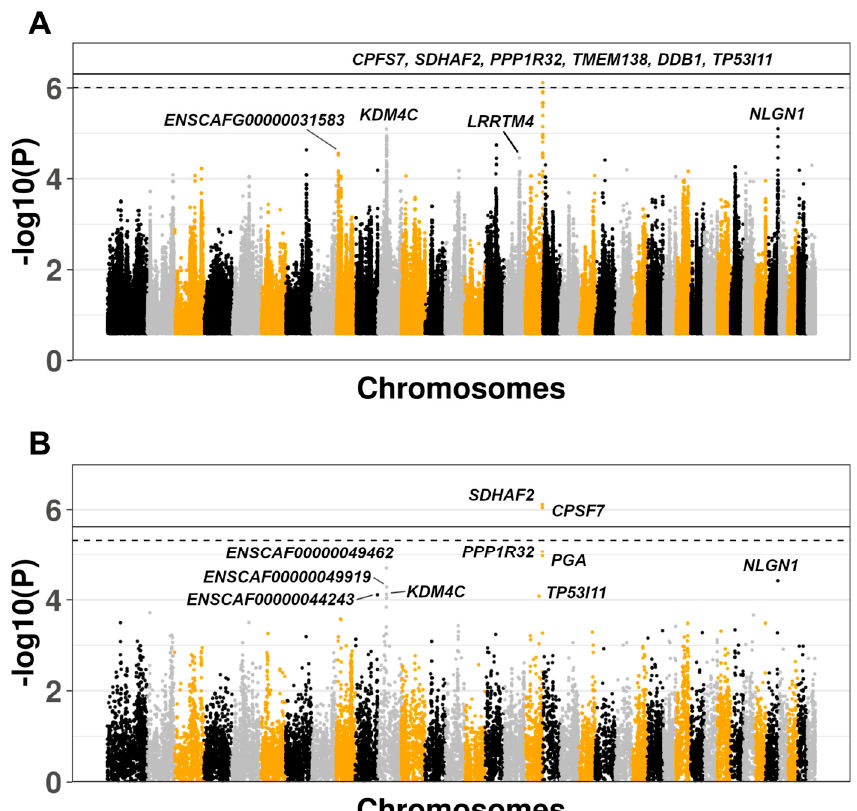
Figure 1. ( A ) SNP level analysis: Manhattan plot of the top 500K SNPs ranked by unadjusted p -value. The continuous and dashed lines indicate the genome-wide ( p < 4.91 × 10 − 7 ) and suggestive ( p < 9.83 × 10 − 7 ) significance thresholds, respectively. The p -value adjustment was conducted using the Bonferroni method, accounting for 101,740 independent SNPs estimated using regional linkage disequilibrium (LD) patterns. Gene names reported are the top 10 according to the SNP level analysis. ( B ) Gene level analysis: Manhattan plot of all the genes ranked by p -value. The continuous and dashed lines indicate the genome-wide and suggestive significance thresholds, respectively. The adjustment was conducted using the Bonferroni method accounting for the total number of genes tested ( n = 18,110). Gene names reported are the top 10 according the gene level analysis.